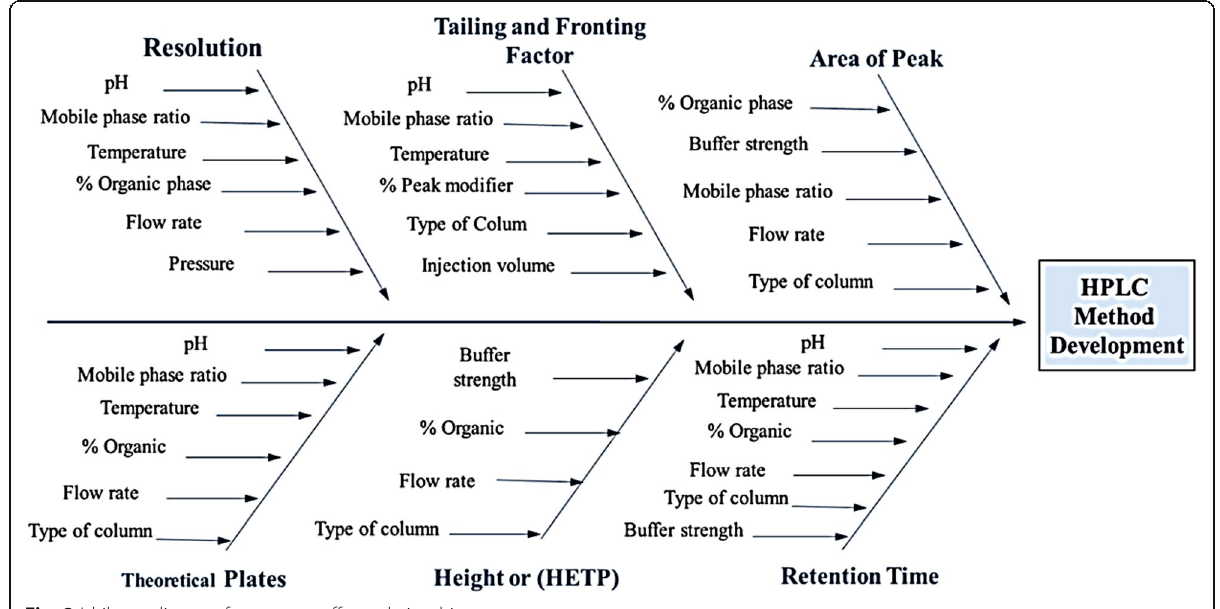
Fig. 2 Ishikawa diagram for a cause – effect